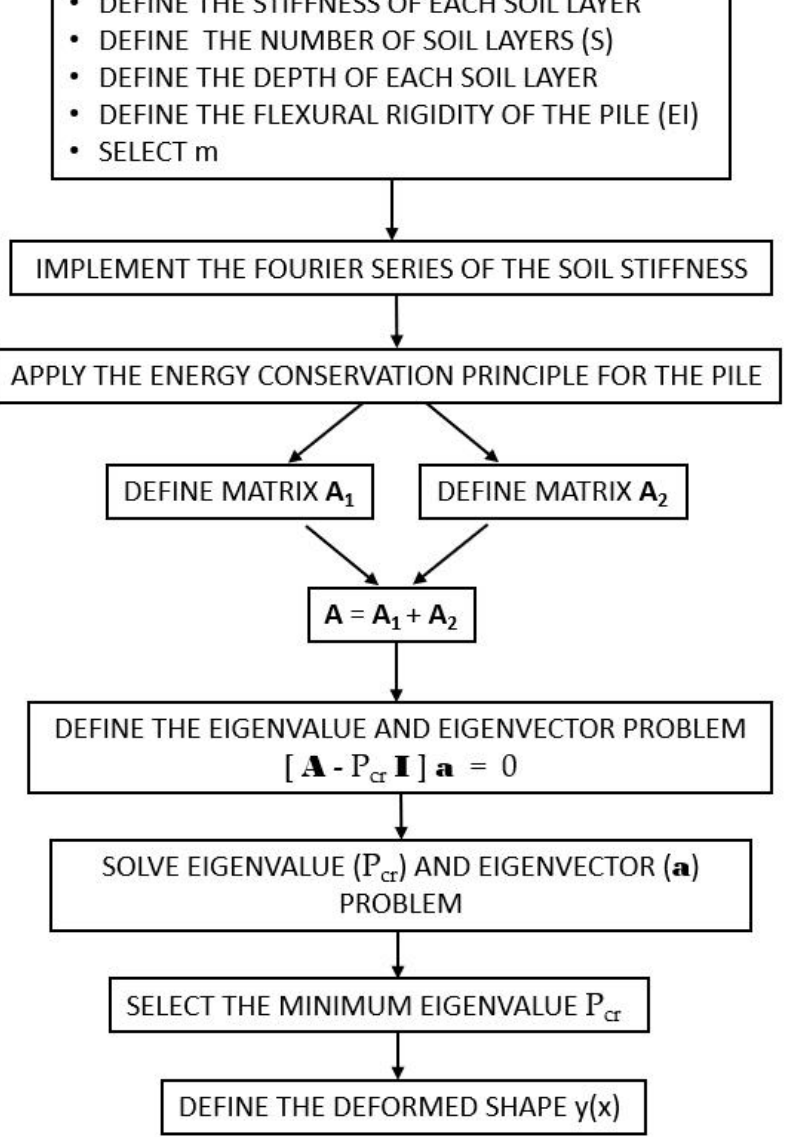
Figure 1. Flowchart of the proposed method for buckling analysis of piles in multi-layered soils.